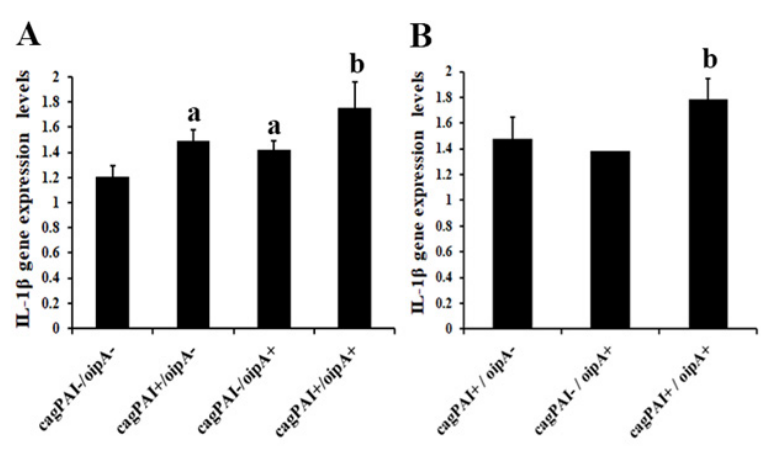
Fig. 1 . IL-1 β gene expression levels in the presence/absence of oip A and cag PAI genes in gastric tissues of subjects with gastritis (A) and PUD (B). a significant differences when compared with double-negative cag PAI / oip A gene status ( p <0.05). b significant differences when compared with single-positive oip A, cag PAI gene status, or double-negative for these two genes ( p <0.05).